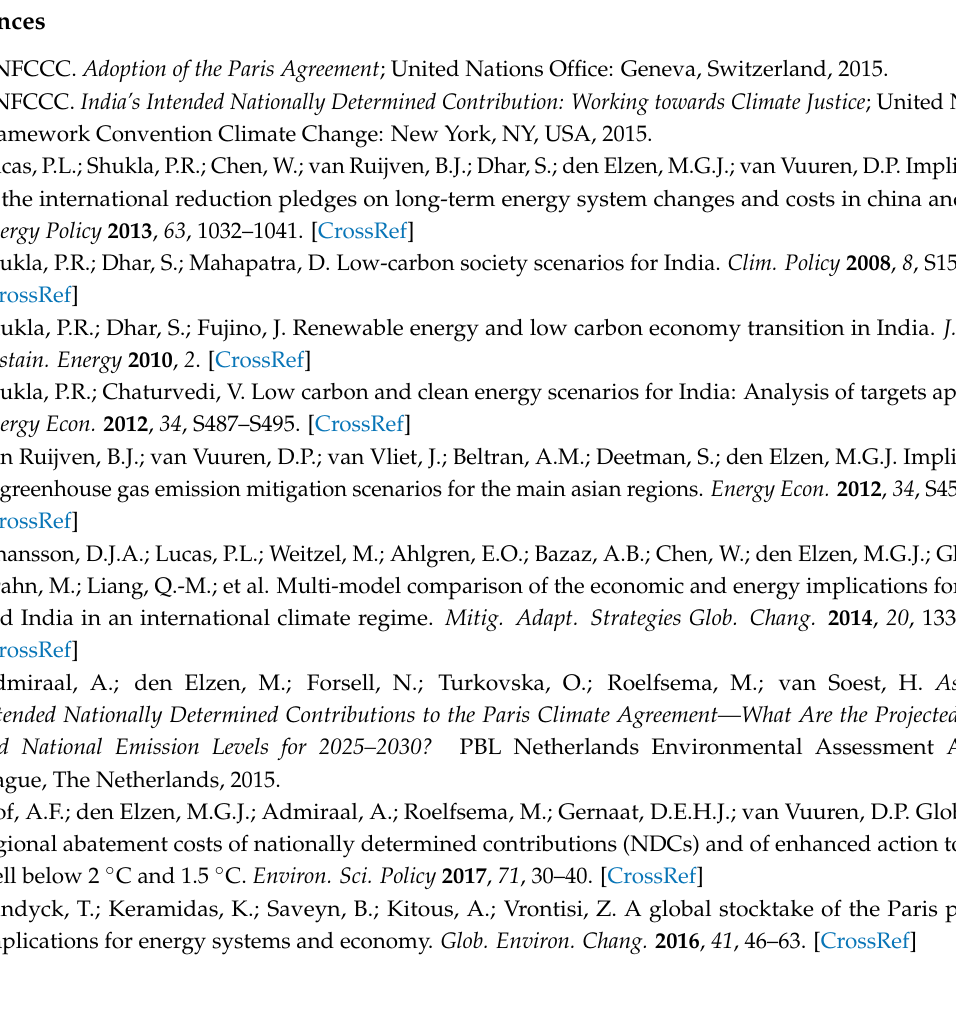
s1. Figure S1: Key indicators in different scenarios, Figure S2: Electricity prices in difference scenarios, Figure S3: CO 2 emissions from power sector in different